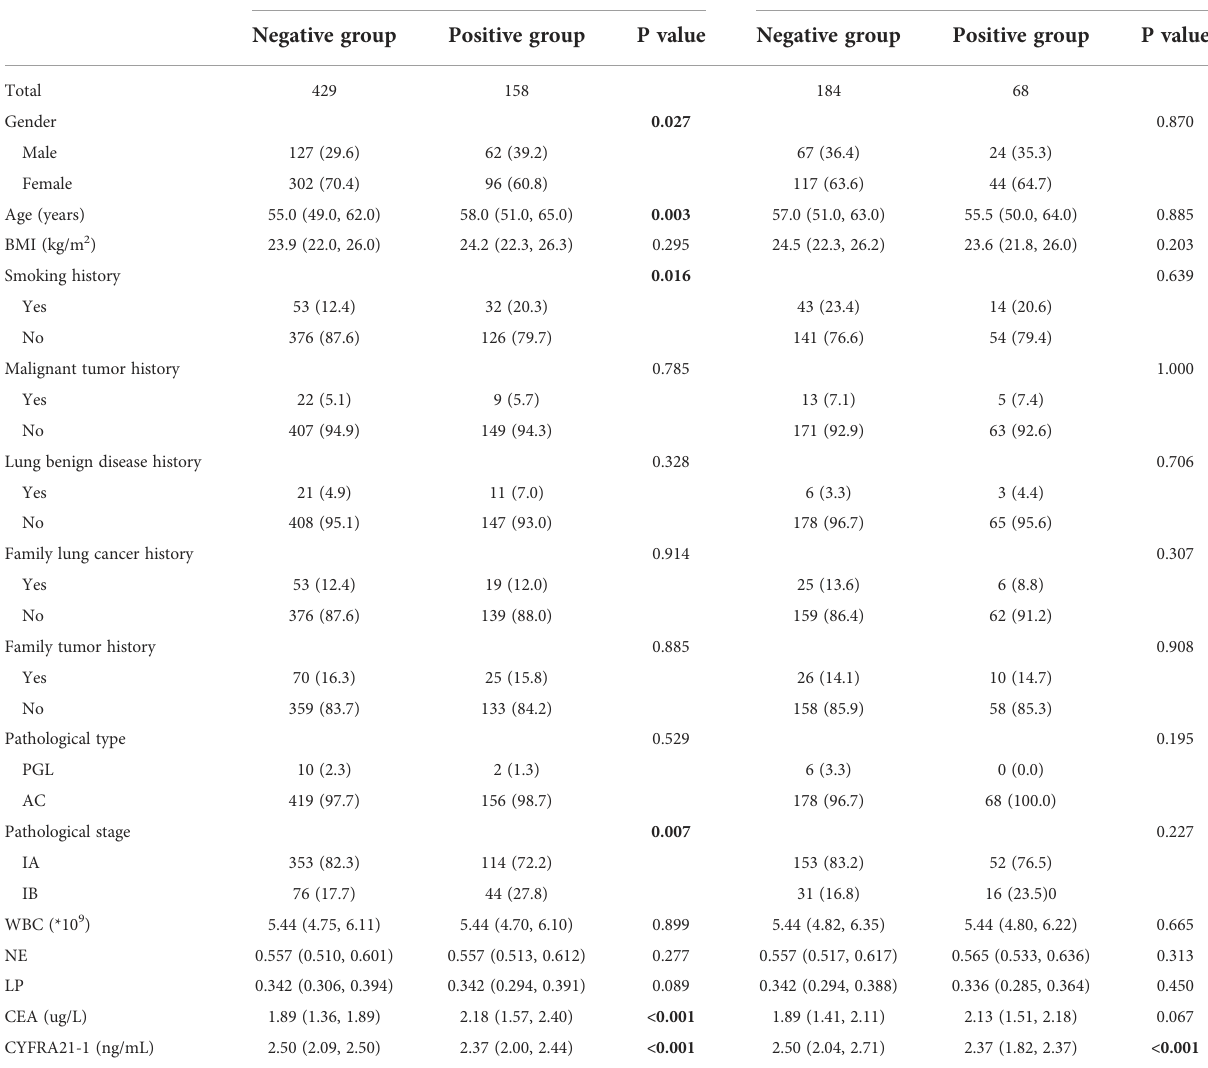
TABLE 2 Comparison of clinicopathologic features in training cohort and test